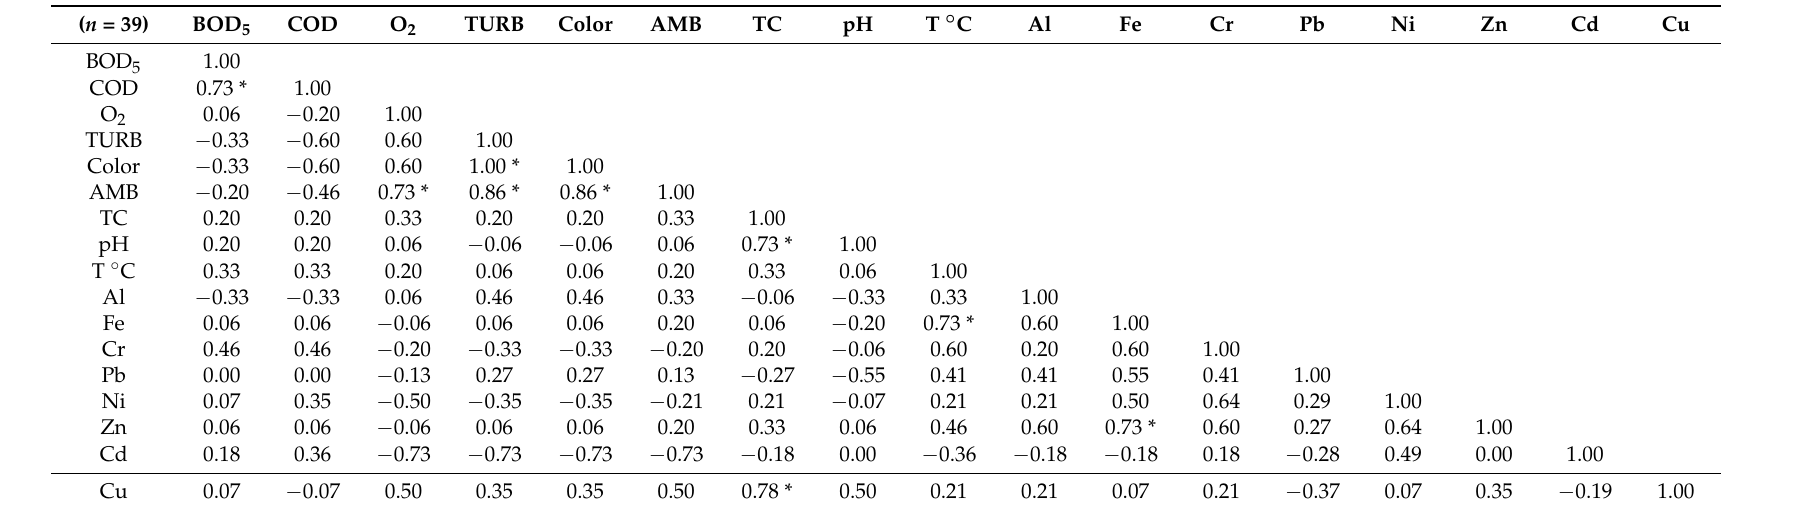
Table 2. Correlation matrix of physicochemical and bacteriologic parameters in Atoyac